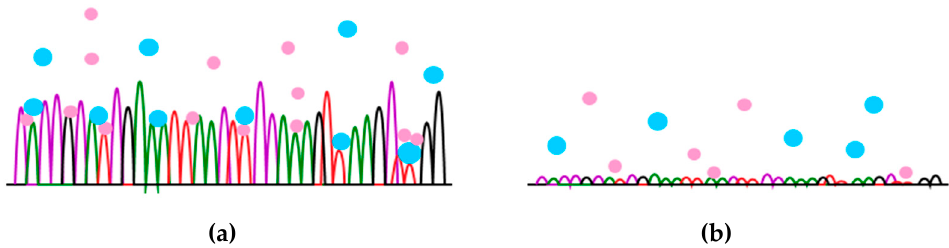
Figure 2. Nanostructured topography of the surface, that attracts ( a ) and repels ( b ) adhesion of